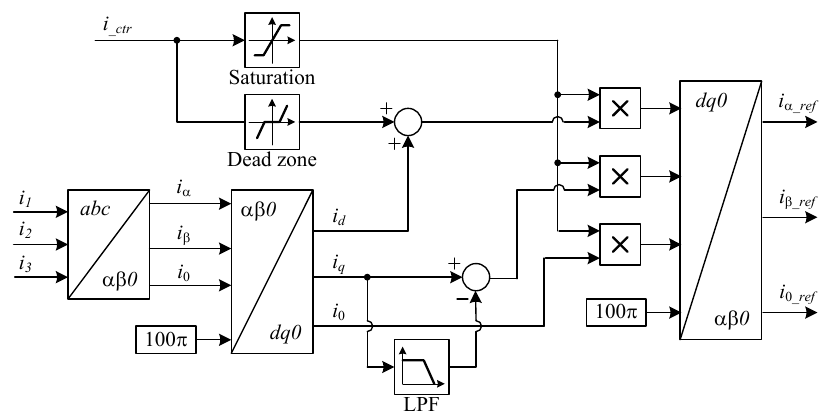
Figure 5. Control scheme for the proposed multilevel inverter.